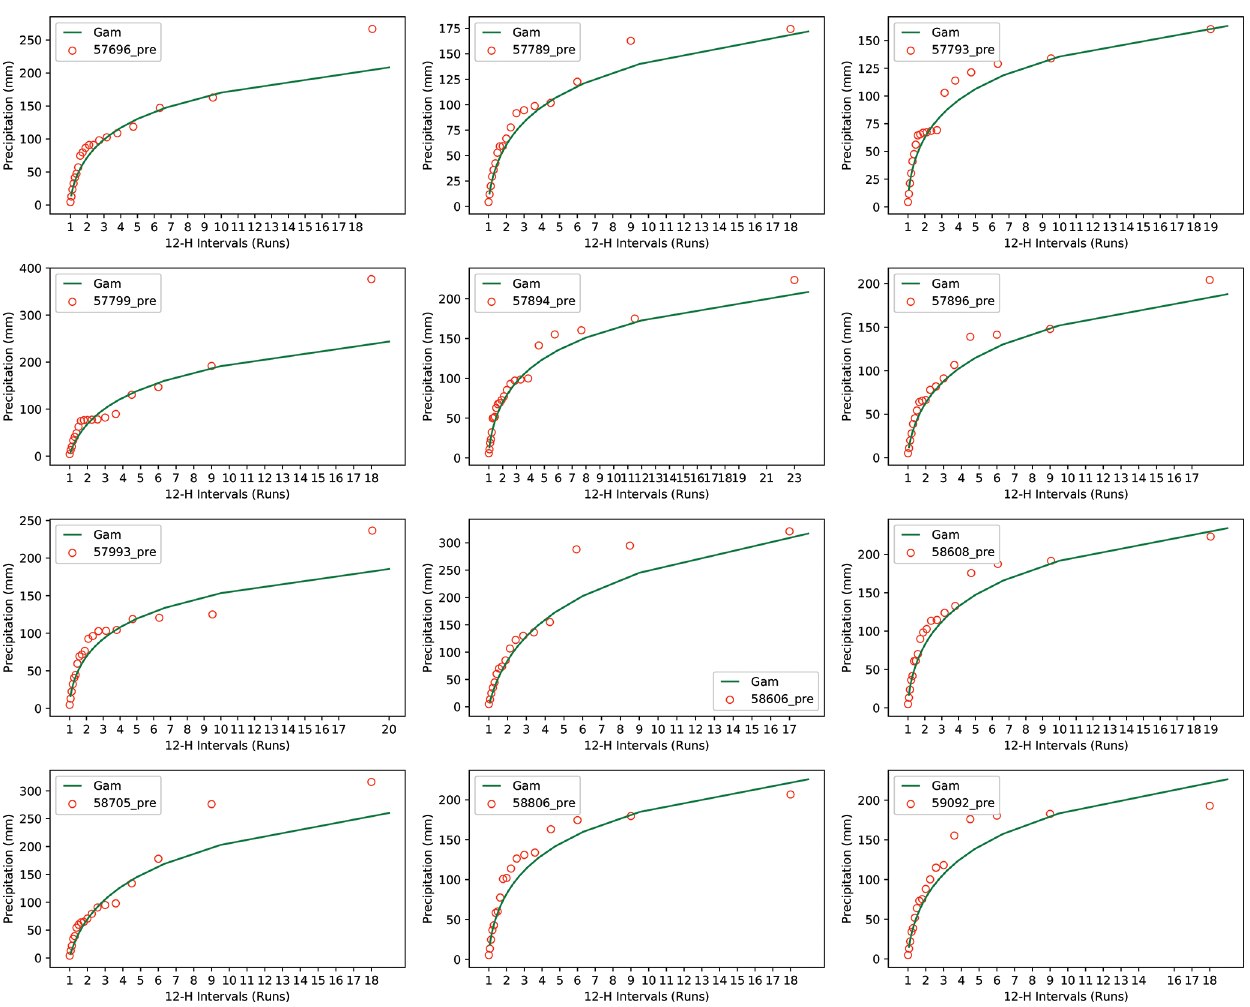
Figure 3. Cumulative precipitation of runs of events. The hollow orange points show observed precipitation events. The green lines represent their gamma estimates. Table 3. Mean parameters α (shape) and β (scale, millimeter per 12h) for the gamma distribution in stations. Stations